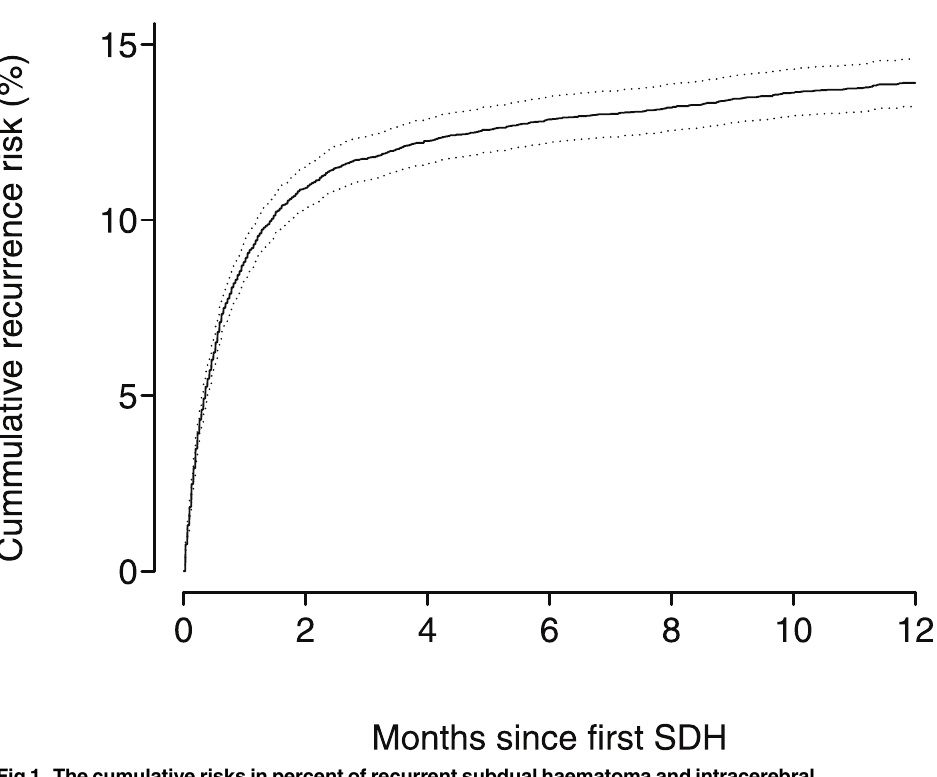
Fig 1. The cumulative risks in percent of recurrent subdual haematoma and intracerebral haemorrhage up to 1 year after the primary bleeding event.